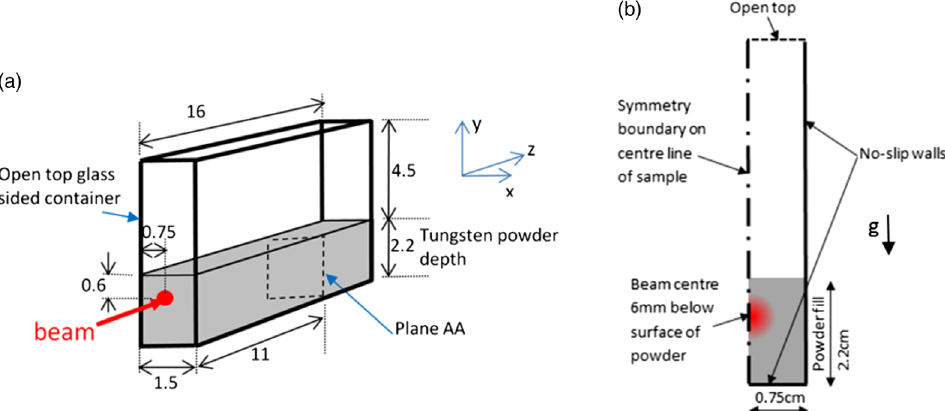
FIG. 1. (a) Sample geometry (dimensions in cm); (b) pseudo-2D computational domain at plane AA showing powder fill initial condition and boundary conditions.